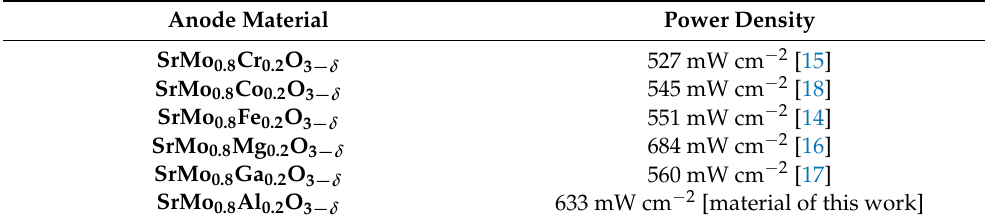
Table 4. Power density values for other similar systems such as SrMo 0.8 M 0.2 O 3 − δ (M = Cr, Co, Fe, Mg, Ga) anodes at 850 ◦